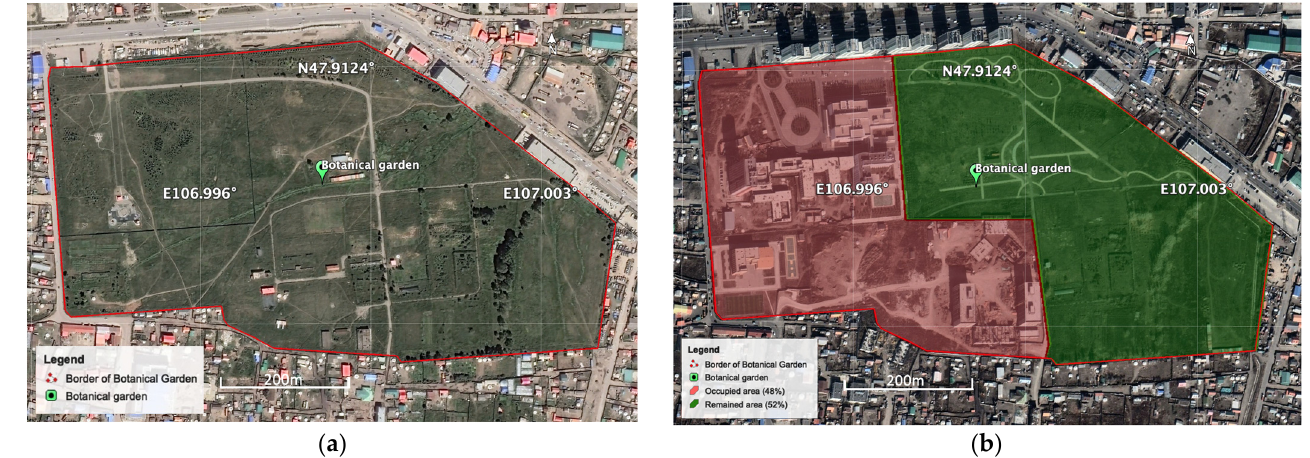
Figure 3. Construction of new facilities at Botanical Garden (2015 and 2021). ( a ) Botanical Garden view from Google map by 2015. ( b ) Botanical Garden view from Google map by 2021.